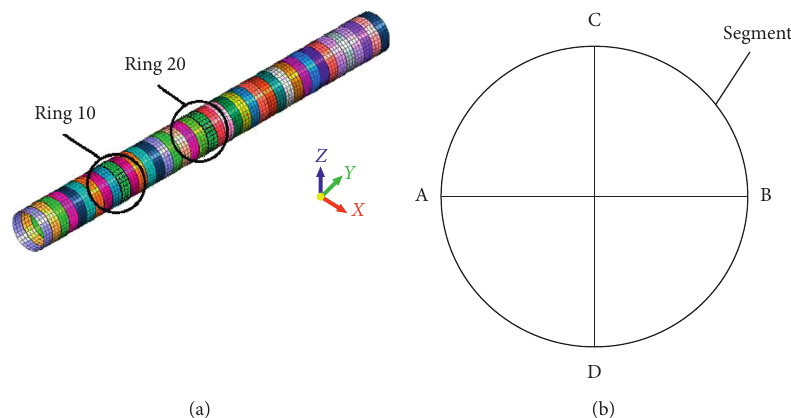
Figure 14: Drawing of prior-dug tunnel segments monitoring. (a) Schematic diagram of prior-dug tunnel segments selection. (b) Diagram of segment monitoring